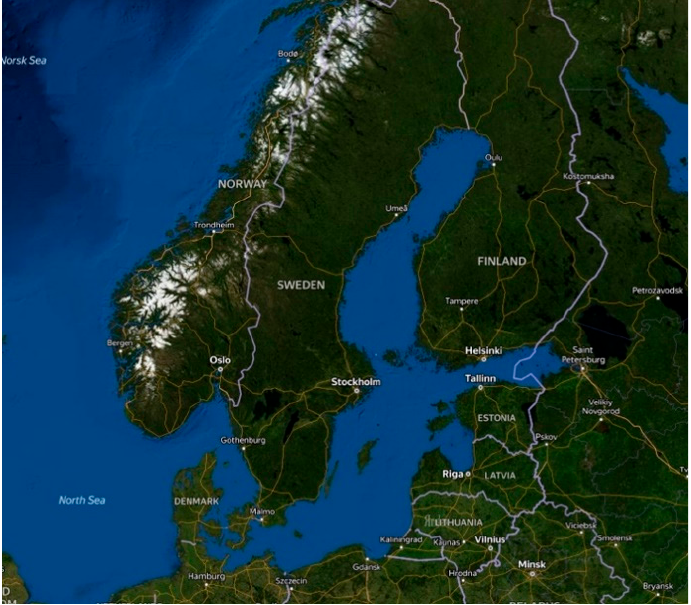
Figure 1. Zoning of the Baltic Sea (Source: https://yandex.ru/maps/ accessed on 11 May 2022). Microalgae generate biologically active forms of substances that greatly influence the microbiota of the Earth. Their influence on the development and growth of pathogenic microorganisms makes them a modern form of natural antibacterial agent [15,16]. C. vulgaris and A. platensis are active producers of proteins, carbohydrates, lipids, and vitamins. The ratio of these compounds is easily adjusted with the change in cultivation conditions: dry biomass grown on ordinary mineral media contains 40–55% protein, 35%